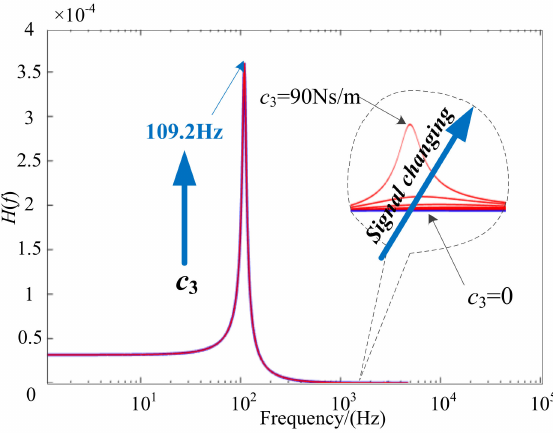
Figure 7. Effects of c 3 on the frequency response of the plastic box.